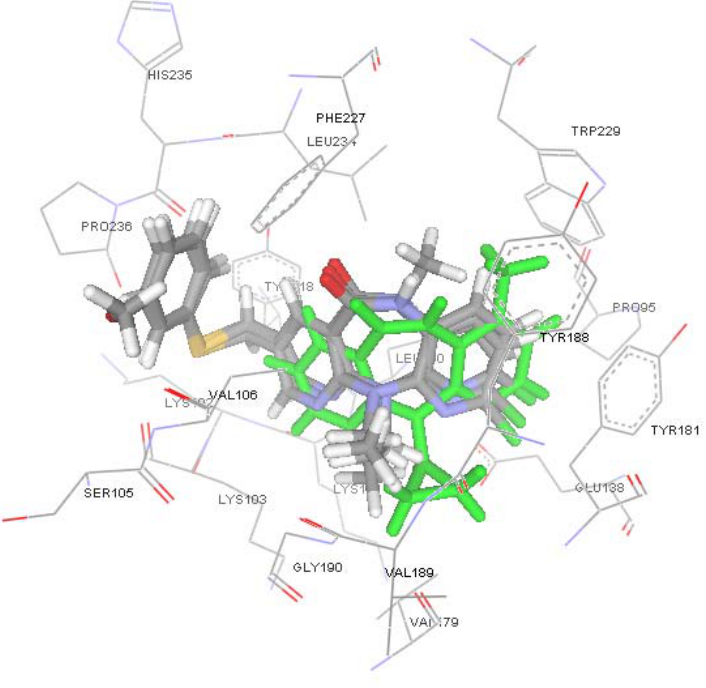
Figure 3 . The binding pocket of enzyme HIV-1 RT with 68nv , T1 and T2 (atom type color) compared with nevirapine